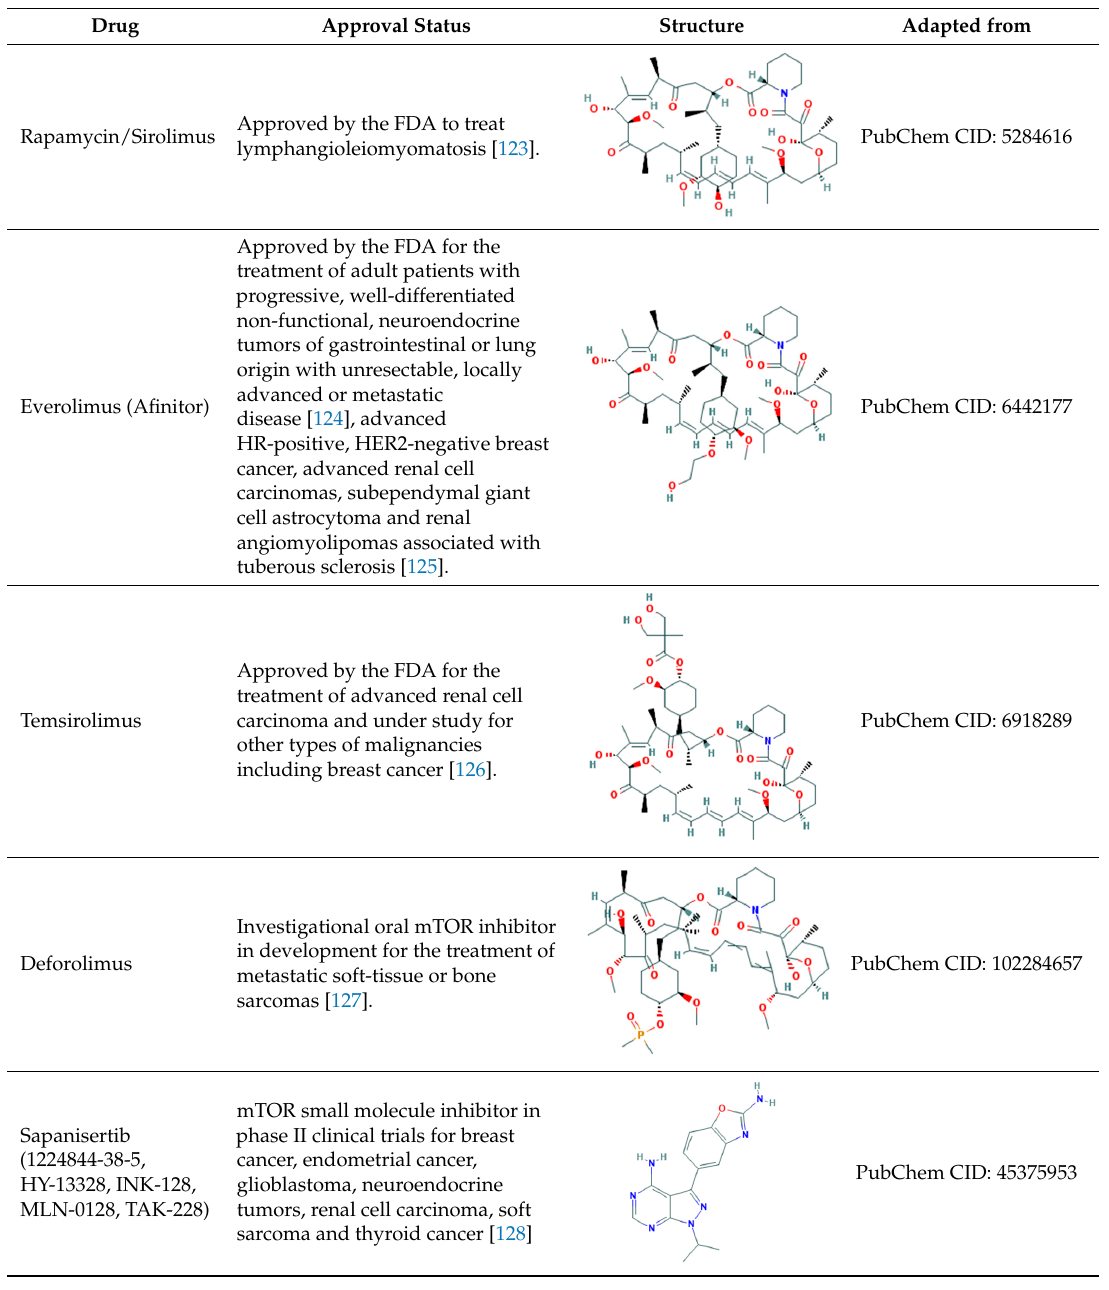
12 of 30 Figure 3. Main altered protein kinase pathways in breast cancer. ( → : Activation; T: Inhibition) 2.3.1. PI3K/Akt/mTOR Targeting Studies